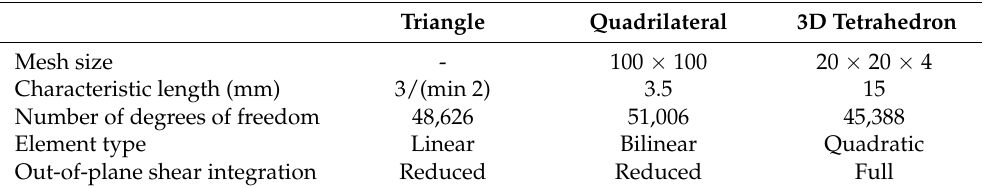
Table 6. Details on finite element mesh.